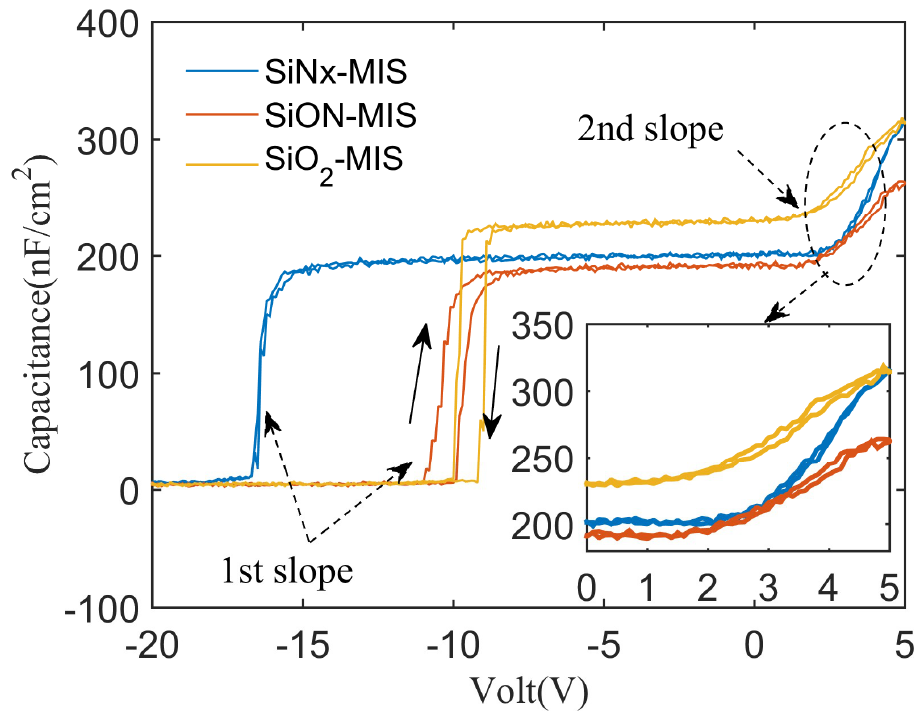
Figure 4. Forward and backward capacitance versus voltage (C-V) measurement with frequency of 1 MHz. Inset: magnified voltage range of 0~5 V.